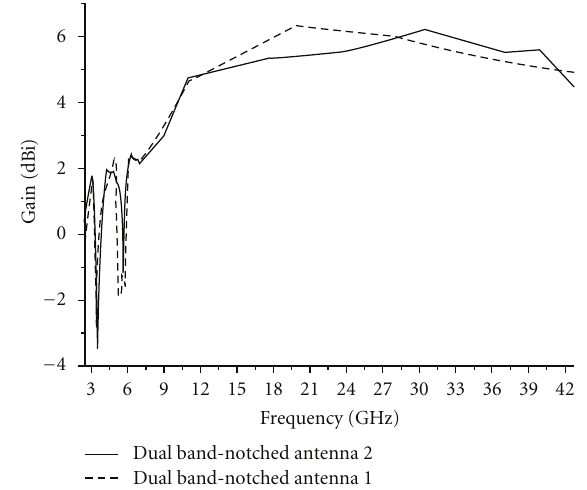
Figure 10: Gains of the proposed antennas.